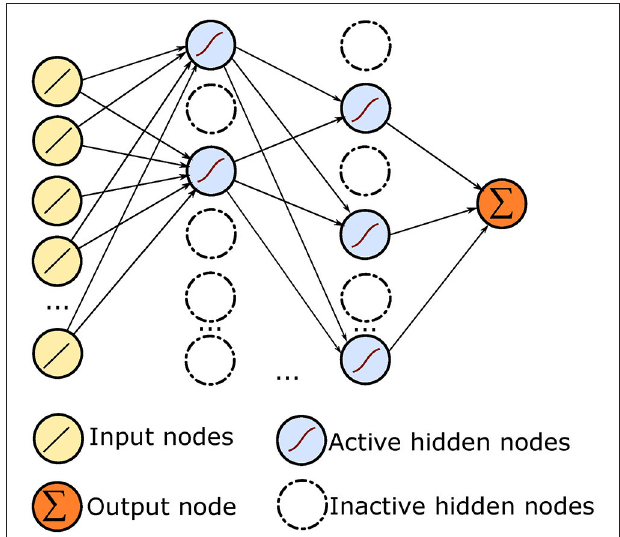
FIGURE 5 | Neural network with dropout.